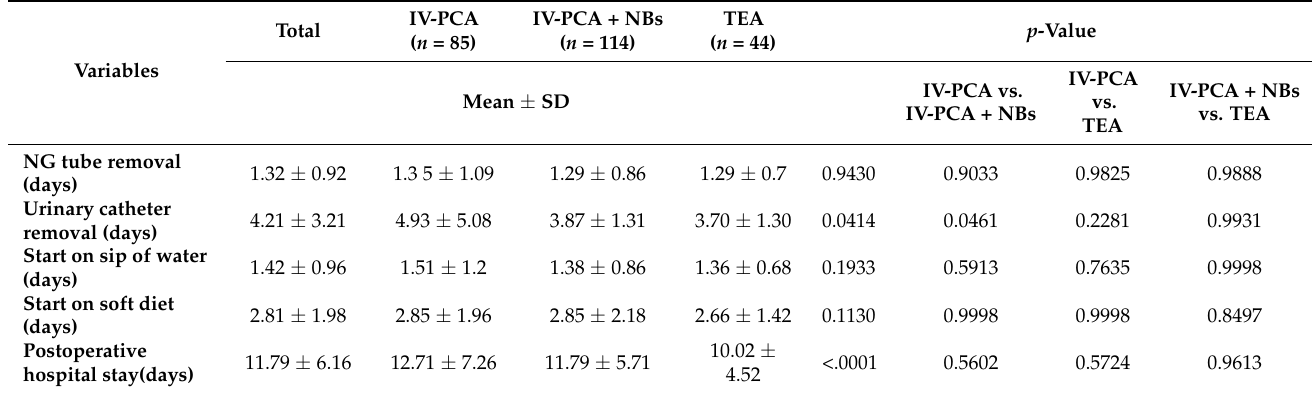
Table 4. Secondary